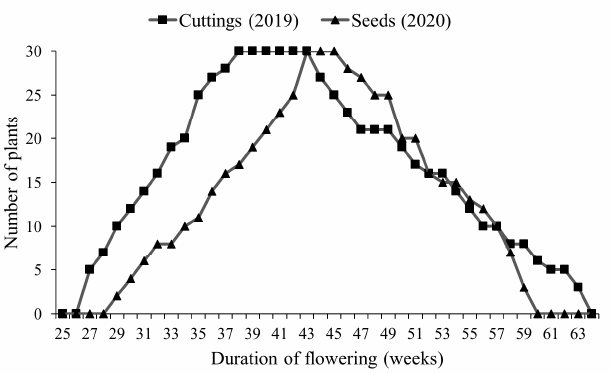
Figure 6. Line graph representing the variation (at weekly intervals) in the duration of flowering with the number of Jasminum parkeri plants ( n = 30) propagated through stem cuttings and seeds.